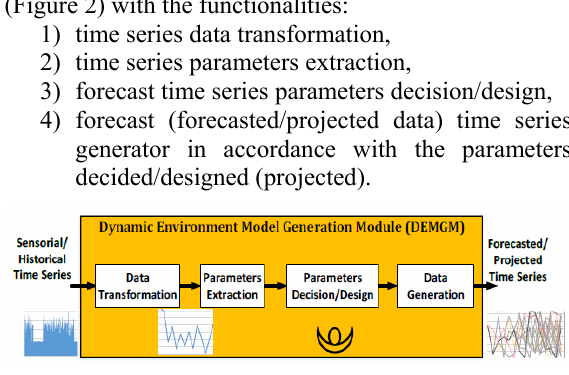
Figure 2. Logical Architecture of Dynamic Environment Model Generator Module (DEMGM).